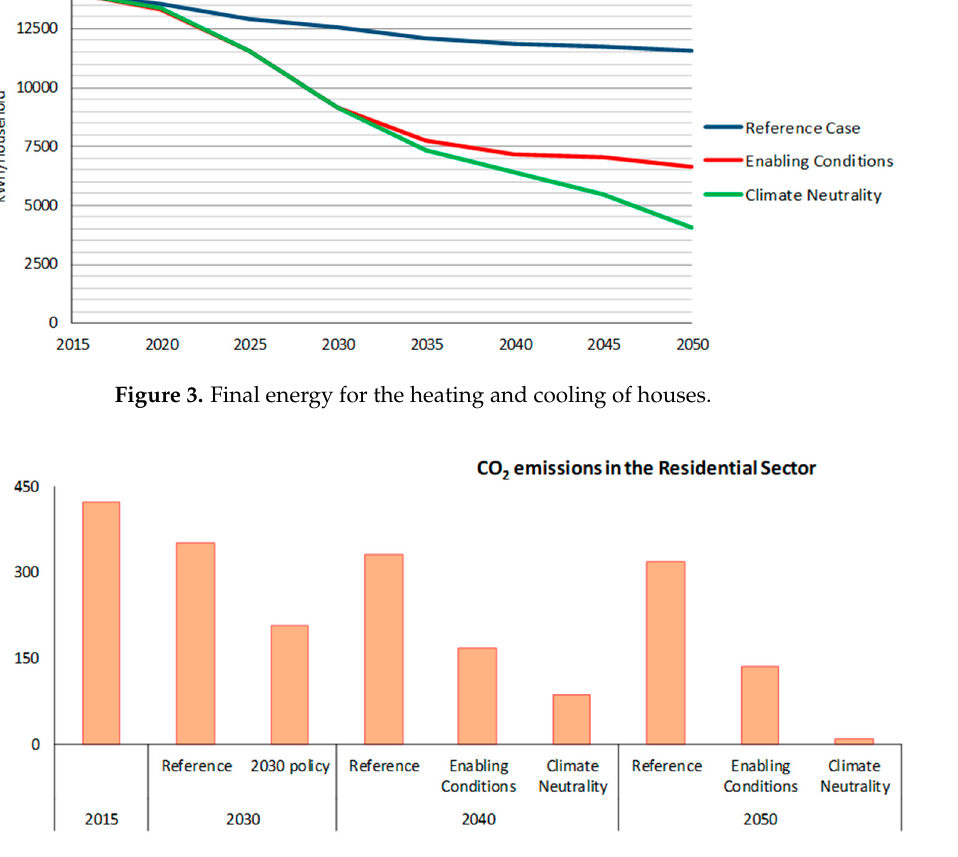
Figure 4. CO 2 emissions in the residential sector in the EU over 2015–2050.